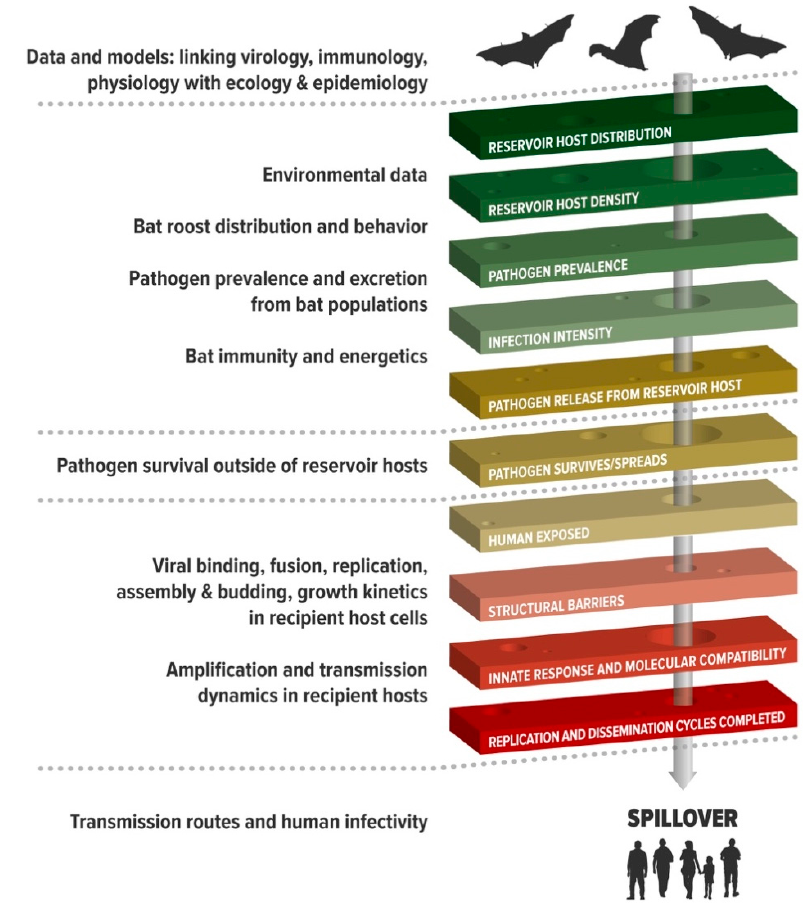
Figure 1. Biological data needed to understand and predict spillover ( left ) aligned to the key mechanisms of spillover ( right ). In addition, epidemiology and social sciences are employed to understand human exposure. Adapted from Plowright et al.